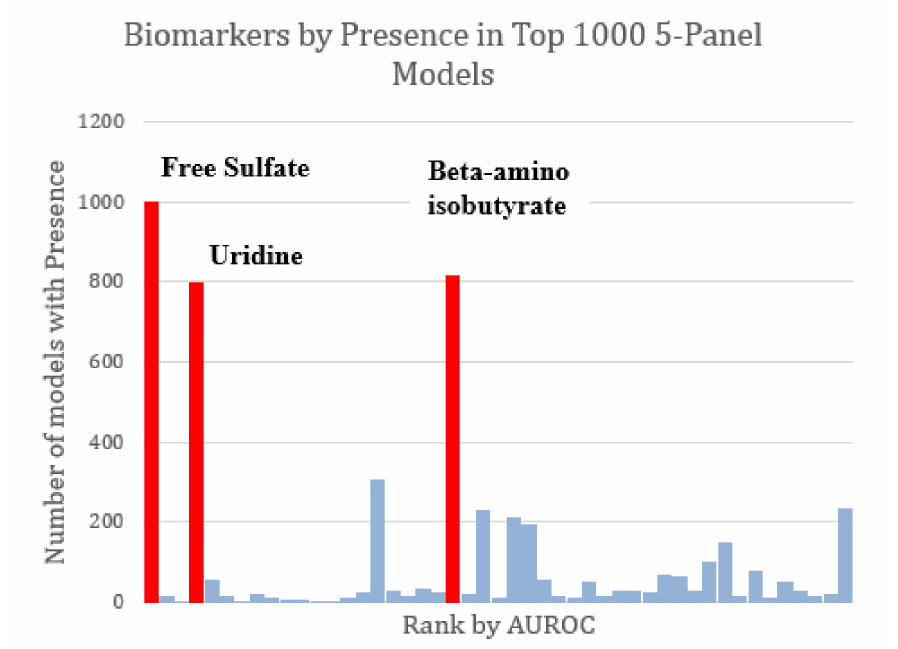
Figure 5. Marker prevalence among the top-1000 FDA 5-marker models as judged by their perfor- mance on the test set. Among the most prominent potential biomarkers are free sulfate, uridine, and beta-amino isobutyrate (highlighted in red). Each of these was present in more than 75% of the top models. Free sulfate in particular was present in every single top